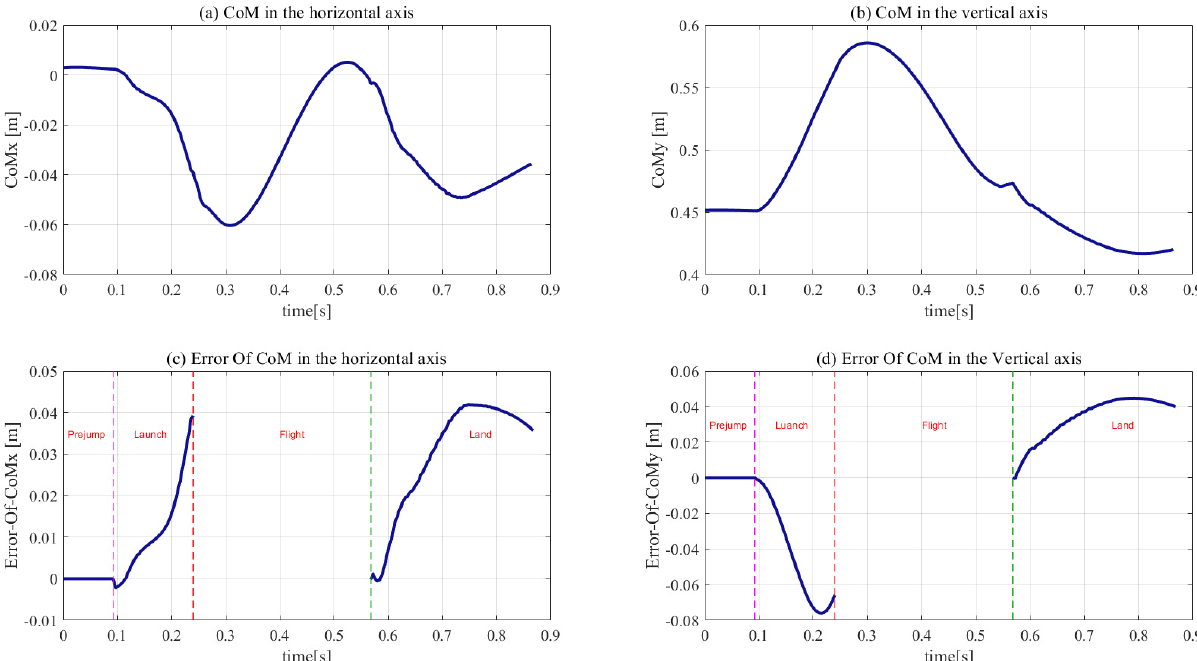
Figure 10. Trajectory of CoM and its simulation error.